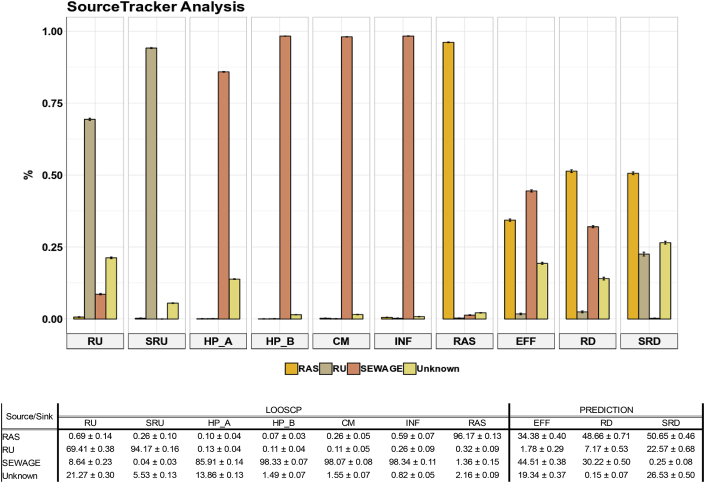
Relative contribution of river upstream sediment and water column, sewage (hospital and community sewage, and influent), RAS, river upstream (water column and sediment), and unknown sources to the wastewater treatment plant effluent and river downstream (water columns and sediment) estimated using SourceTracker analysis. Where CM = community wastewater, HP = hospital wastewater (HP_A and HP_B), INF = WWTP influent, RAS = return activated sludge, EFF = WWTP liquid effluent, RD = downstream river water column, RU = upstream river water column, SRD = sediment river downstream, and SRU = sediment river upstream.